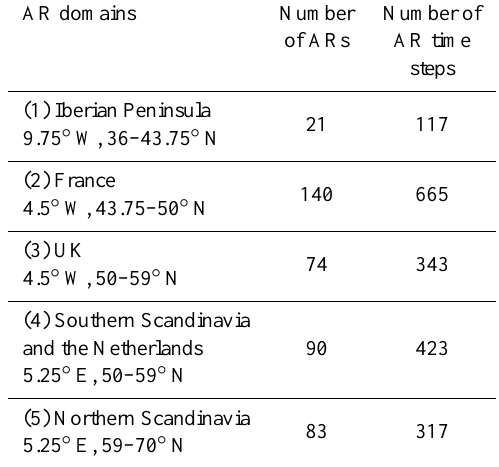
Table 2. The newly defined atmospheric river landfall domains and the corresponding number of atmospheric rivers and the respective number of time